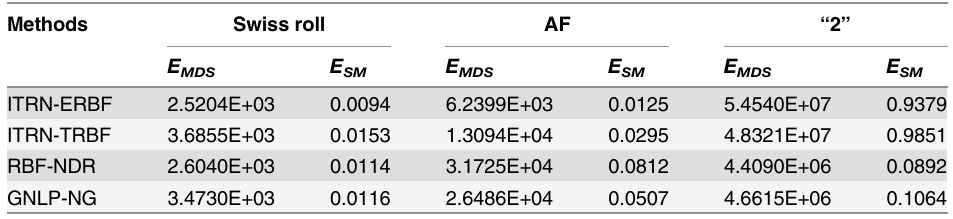
Table 1. Stress functions for different